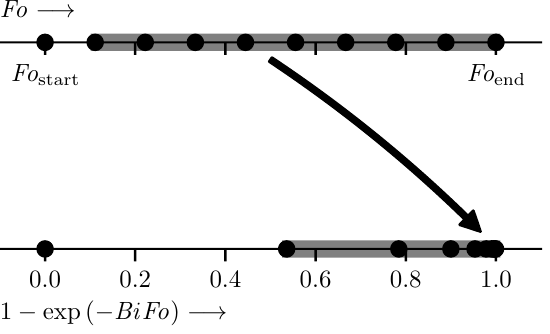
Figure 3. Effect of linearly spacing Fo